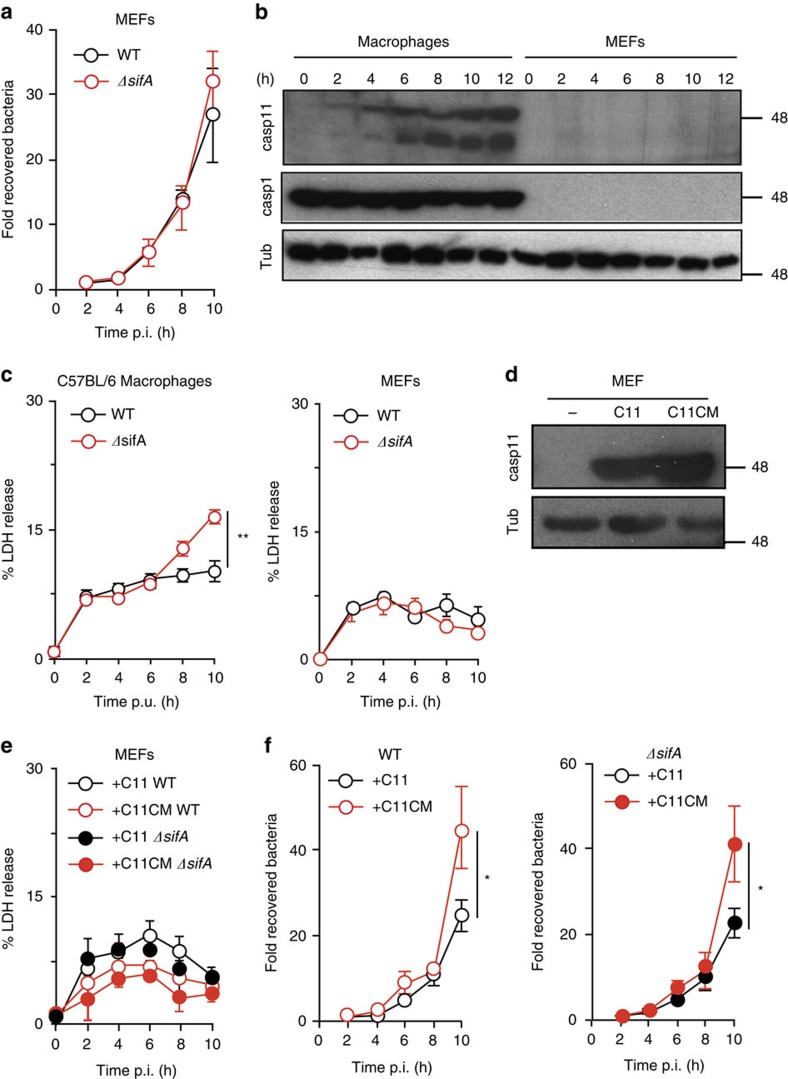
Expression of caspase-11 in MEFs reduces growth of Salmonella.(a) MEFs were infected with WT or ΔsifA Salmonella then lysed at the indicated time points. Bacterial CFUs were counted on LB agar and normalized to CFUs at 2 h p.i. (b) Protein extracts from iBMDMs or MEFs, infected with ΔsifA Salmonella for the times indicated, were immunoblotted for caspase-11 (Casp11), caspase-1 (Casp1) or Tubulin (Tub) as a control. (c) Cytotoxicity of iBMDMs or MEFs, infected with WT or ΔsifA Salmonella, was quantified by release of LDH at the indicated times. post-uptake (p.u.). (d) MEFs, retrovirally transduced with vector encoding caspase-11 (C11) or a catalytic mutant (C11CM) were immunoblotted with caspase-11 or Tubulin antibodies and compared with control-treated cells. (e,f) Cells described in (d) were infected with WT or ΔsifA Salmonella prior to kinetic analysis of LDH release (e) and enumeration of bacterial CFUs on LB agar (f). Data are the mean and s.e.m. from three experiments (a,c,e,f) or are representative of two experiments (b,d). Student's t-test, *P<0.05.